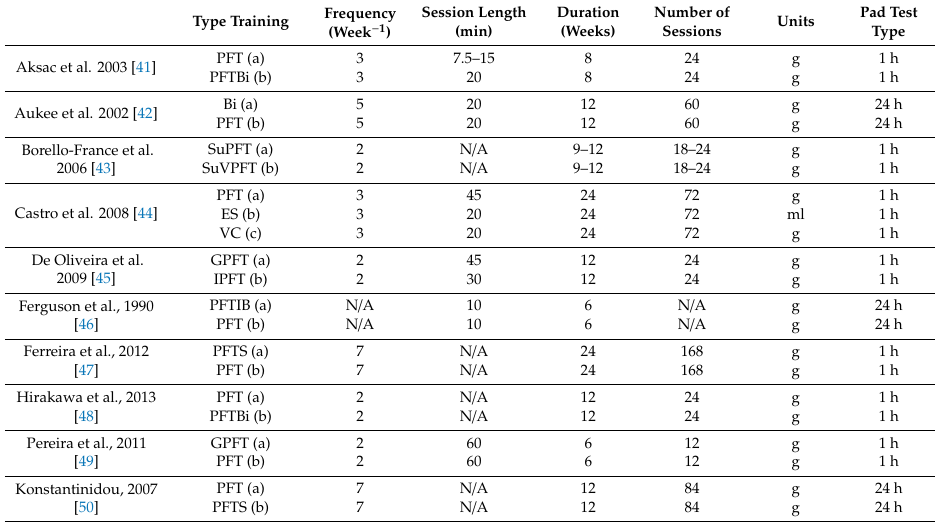
Table 2. Characteristics of pelvic floor training intervention and urinary loss assessment of the studies included in the meta-analysis.